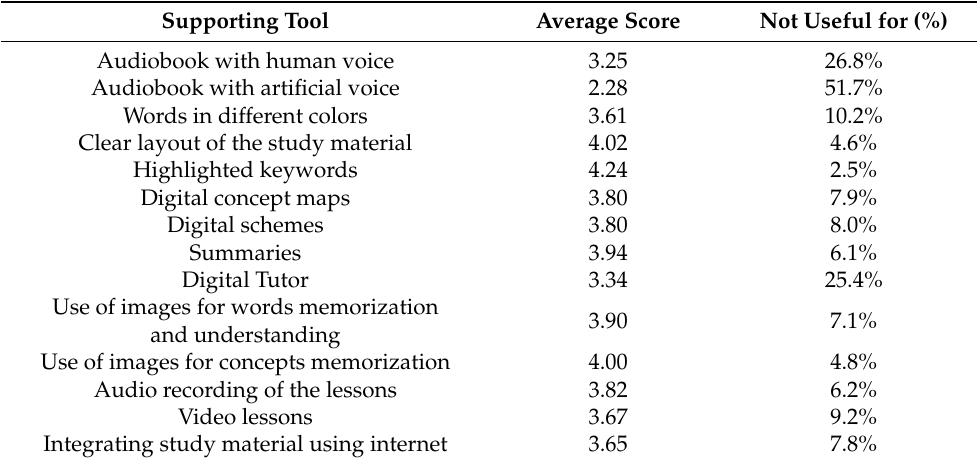
Table 6. Average score given by dyslexic students in the questionnaire to the usefulness of each supporting tool, from 1 (very little useful) to 5 (very much useful) and percentage of students that found it useless.